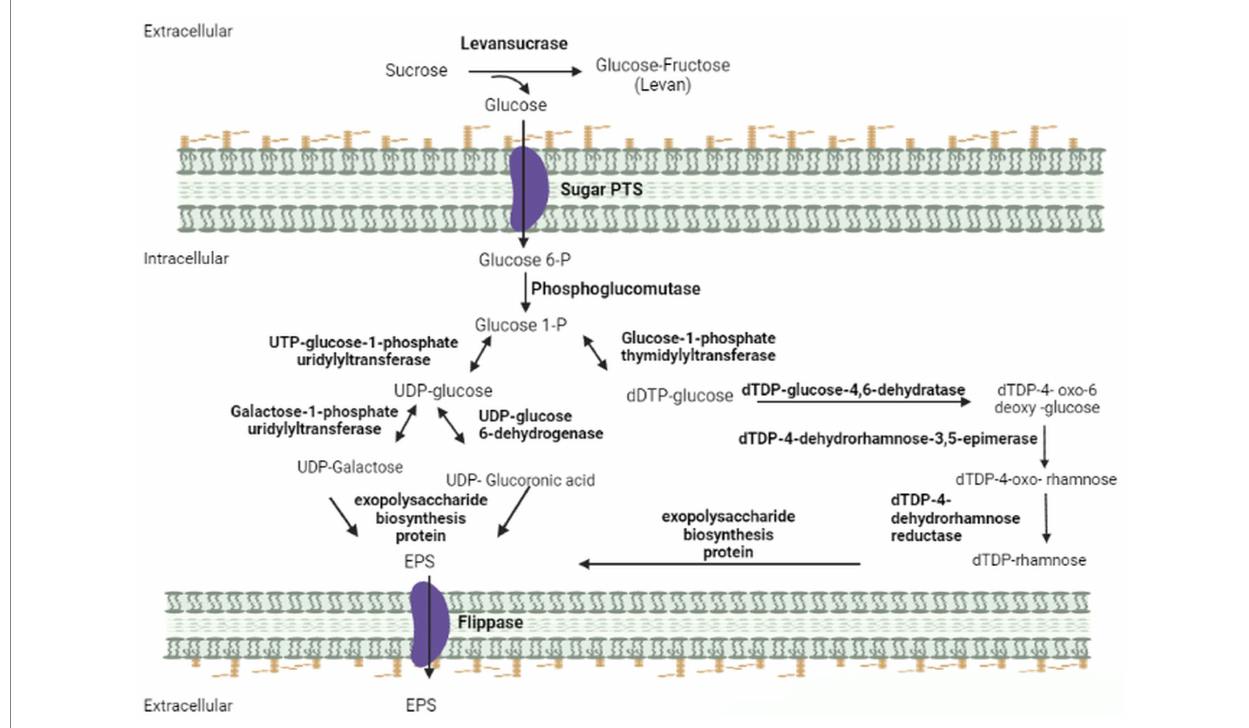
FIGURE 3 Representation of the metabolic pathway of EPS production found in the IPAC21 genome. The diagram demonstrates the enzymes found using KEGG and Metacyclic annotation programs. Levansucrase (EC 2.4.1.10); sugar PTS (EC 2.7.1.-); phosphoglucomutase (EC 5.4.2.2); UTP-glucose-1-phosphate uridylyltransferase (EC 2.7.7.9); glucose-1-phosphate thymidylyltransferase (EC 2.7.7.24); galactose-1-phosphate uridylyltransferase (EC 2.7.7.12); UDP- glucose-6-dehydrogenase (EC 1.1.1.22); dTDP-glucose-4,6-dehydratase (EC 4.2.1.46); dTDP-4-dehydrorhamnose-3,5-epimerase (EC 5.1.3.13); dTDP-